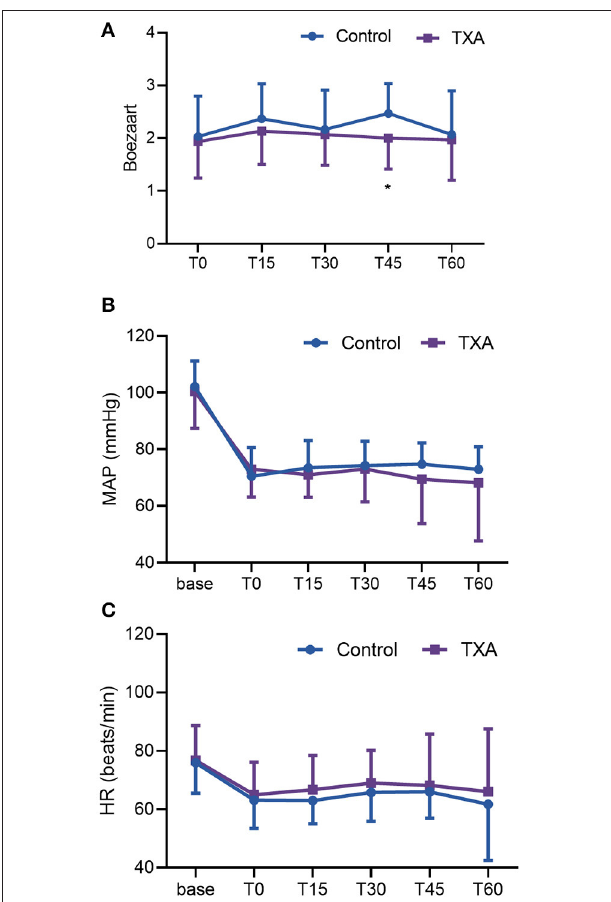
FIGURE 4 | (A) Boezaart scores in the first 60 mins. (B) MAP in the first 60 mins. (C) HR in the first 60 mins. The dots represent the means of each group at the following times: before anesthesia (base); the beginning of the operation (T0); and 15 mins (T15), 30 mins (T30), 45 mins (T45), and 60 mins (T60) into the operation. One-sided bars represent the standard deviation. TXA, tranexamic acid; HR, heart rate; MAP, mean arterial